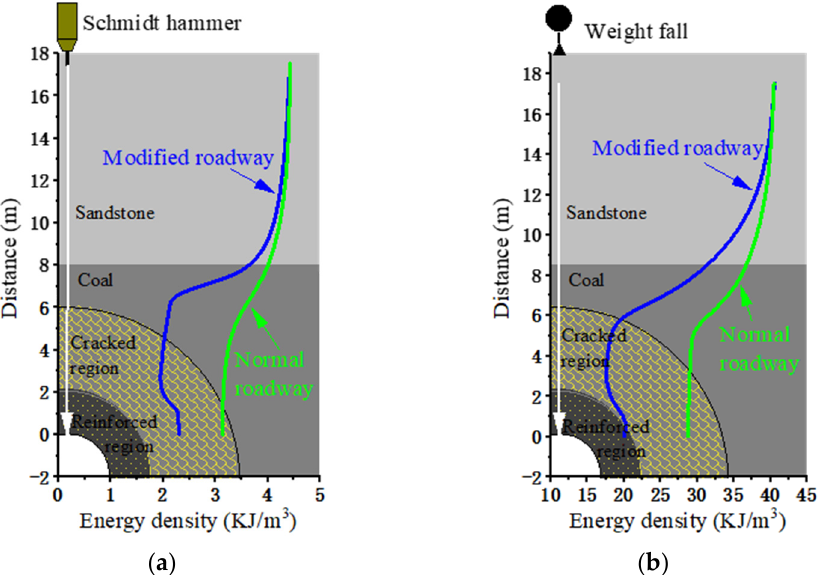
Figure 10. Energy density along the propagation path of impact load by ( a ) a Schmidt hammer and ( b ) a falling weight above the normal roadway and modified roadway.